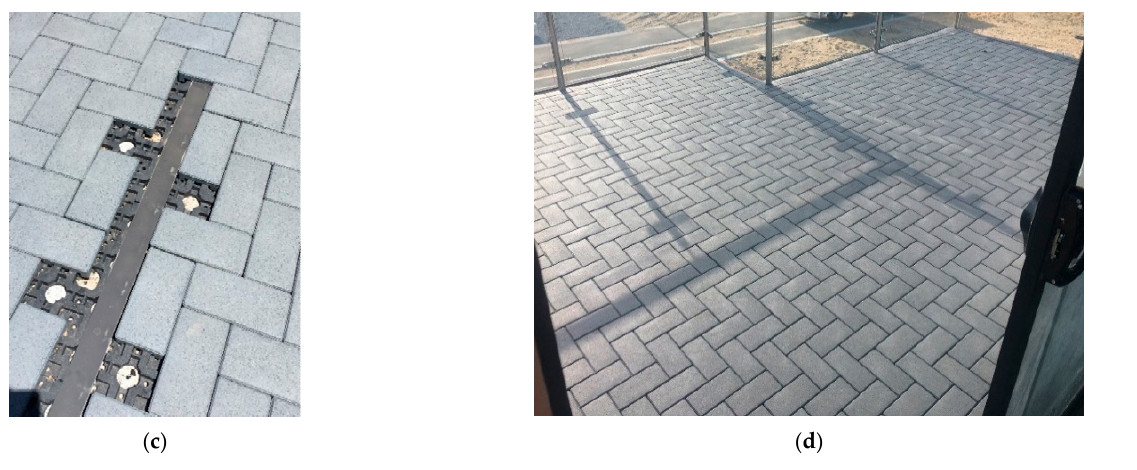
Figure 7. ( a ) Silo flashing running down the balcony pictured in ( c ); ( b ) overflashing design is waterproof, it aligns with the installation and disassembly process (top) and is concealed by a recycled rubber and plastic interlocked paving system, as in ( d ).